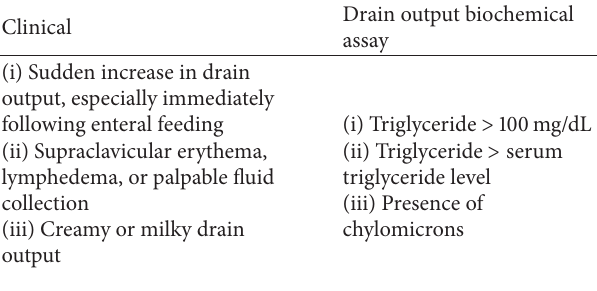
Table 1: Diagnosing a chyle